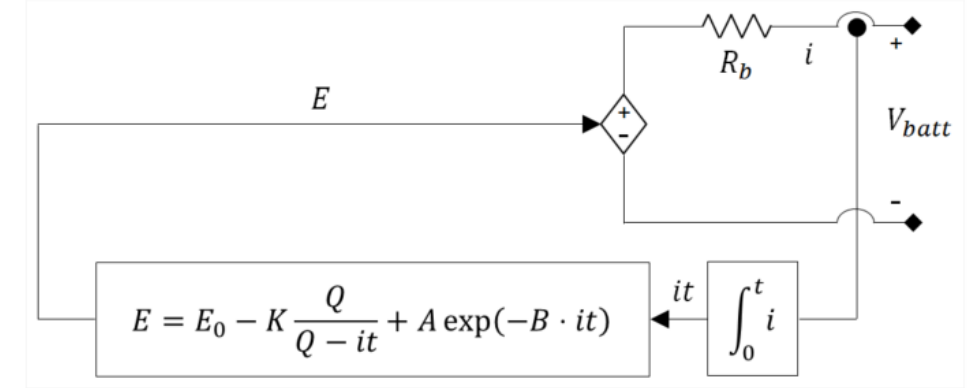
Figure 5. Circuit schematic for battery model.